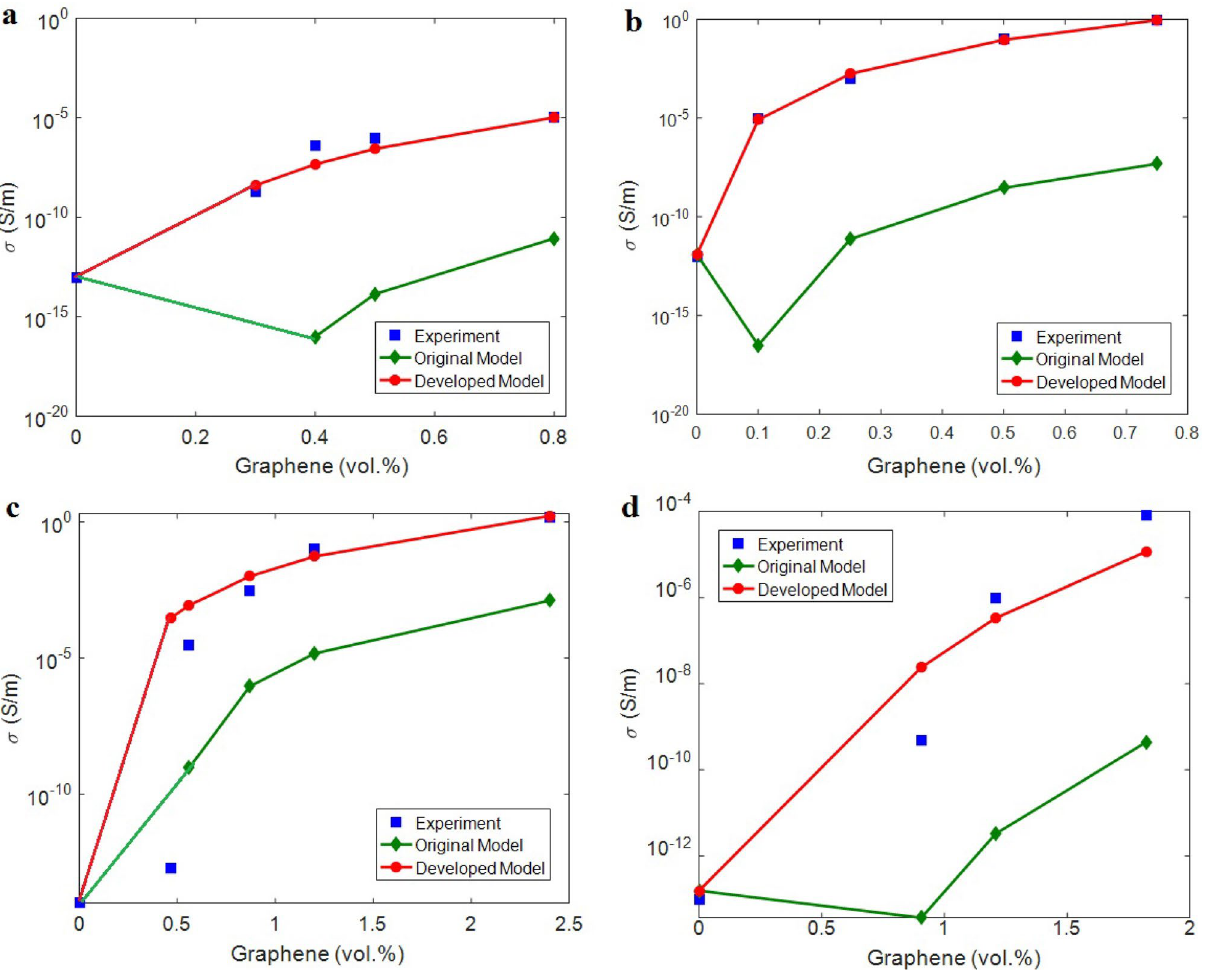
Figure 2. The experimented and theoretical values of conductivity by Eqs. (1) and (8) for ( a ) PVDF 36 , ( b ) PS 62 , ( c ) PET 34 and ( d ) epoxy 63 graphene cases.